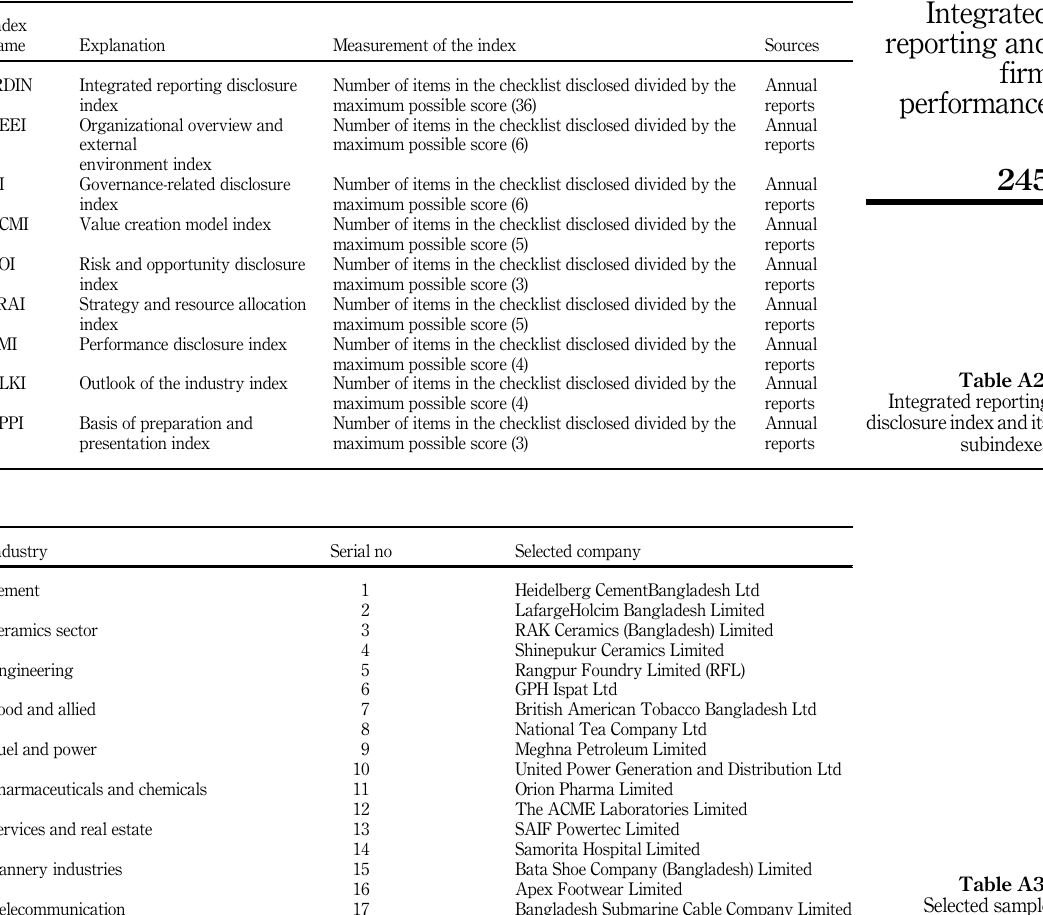
Table A3. Selected